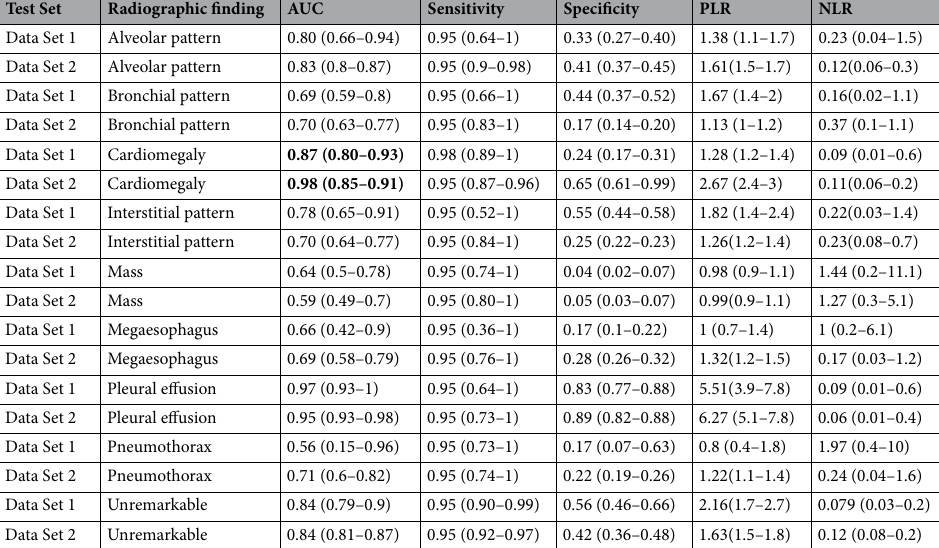
Table 3. Performances of DenseNet-121 in Data Set 1 and Data Set 2. Parentheses show 95% CIs. AUC area under the receiver operator curve, PLR positive likelihood ratio, NLR negative likelihood ratio. Most relevant results have been